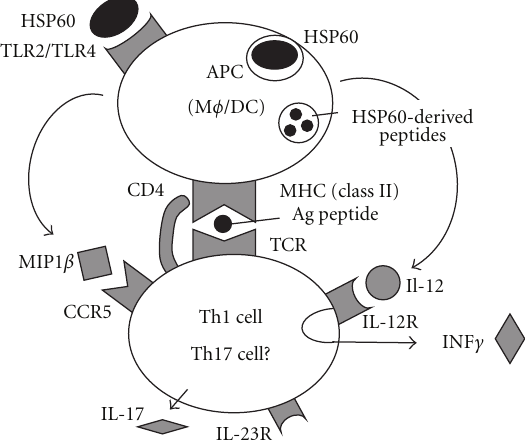
Figure 4: HSP60 regulates Th1 cell di ff erentiation through multiple pathways, a hypothesis. The interactions between TCR- and HSP- derived peptides on MHC [22] and between IL-12 and its receptor [8–10] may induce aberrant T-cell di ff erentiation in patients with BD (Figure 4). The interaction between MIP1 β and C-C-type chemokine receptor (CCR)5 was suggested to induce migration of the pathogenic T cells [8]. TLR2/6 heterodimer is involved in IL-6 production [51] and thus we need to study the expression of the heterodimer in patients with